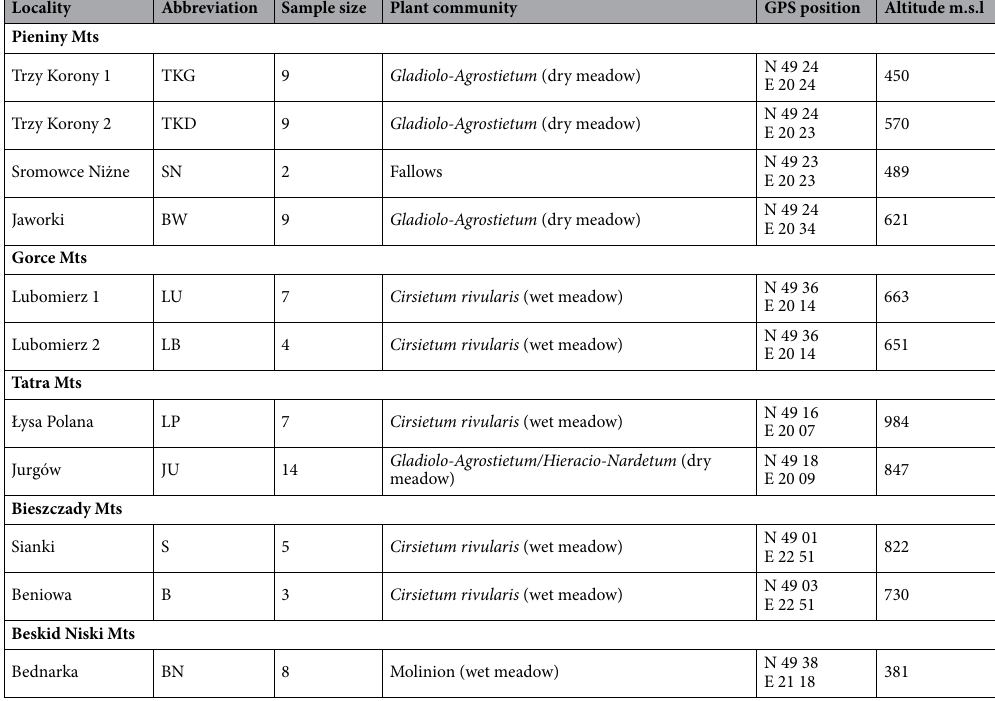
Table 1. Locations of Gladiolus imbricatus taken for the study in the Polish